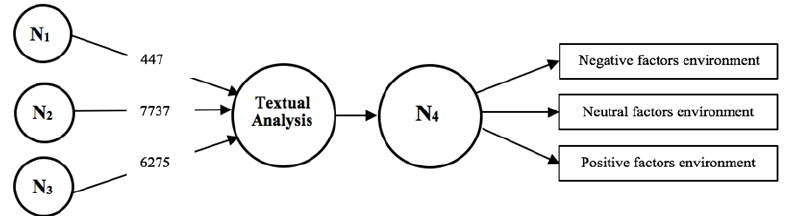
Figure 2. Relationship of Nodes and number of tweets for environment factors identification. Table 8. Results for N 1 for environment factors identification.